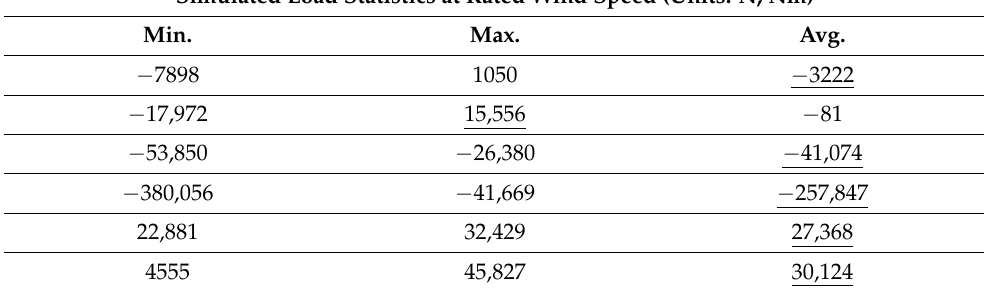
Table 2. Simulated load statistics at rated wind speed. Simulated Load Statistics at Rated Wind Speed (Units: N,